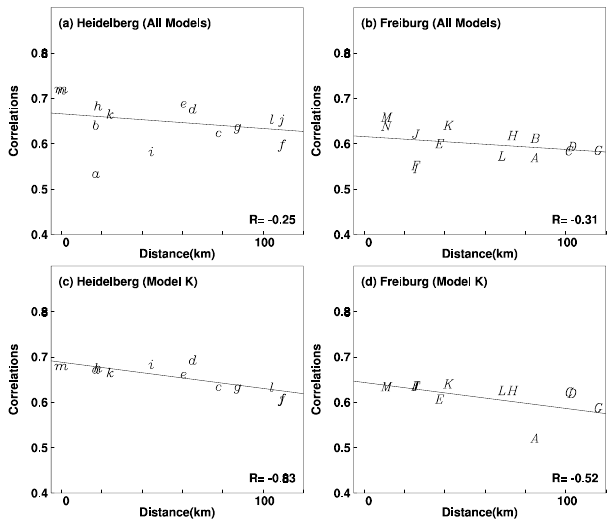
Fig. 4. Correlations between simulations and measurements of hourly concentrations of 222 Rn and the distance of sampling point from the monitoring site for (a) Heidelberg JJA 2002, (b) Freiburg JJA 2002. Correlations from model K for Heidelberg JJA 2002 (c) and for Freiburg JJA 2002 (d) . See text for details. Where sam- pling locations are the same for different models only one letter is